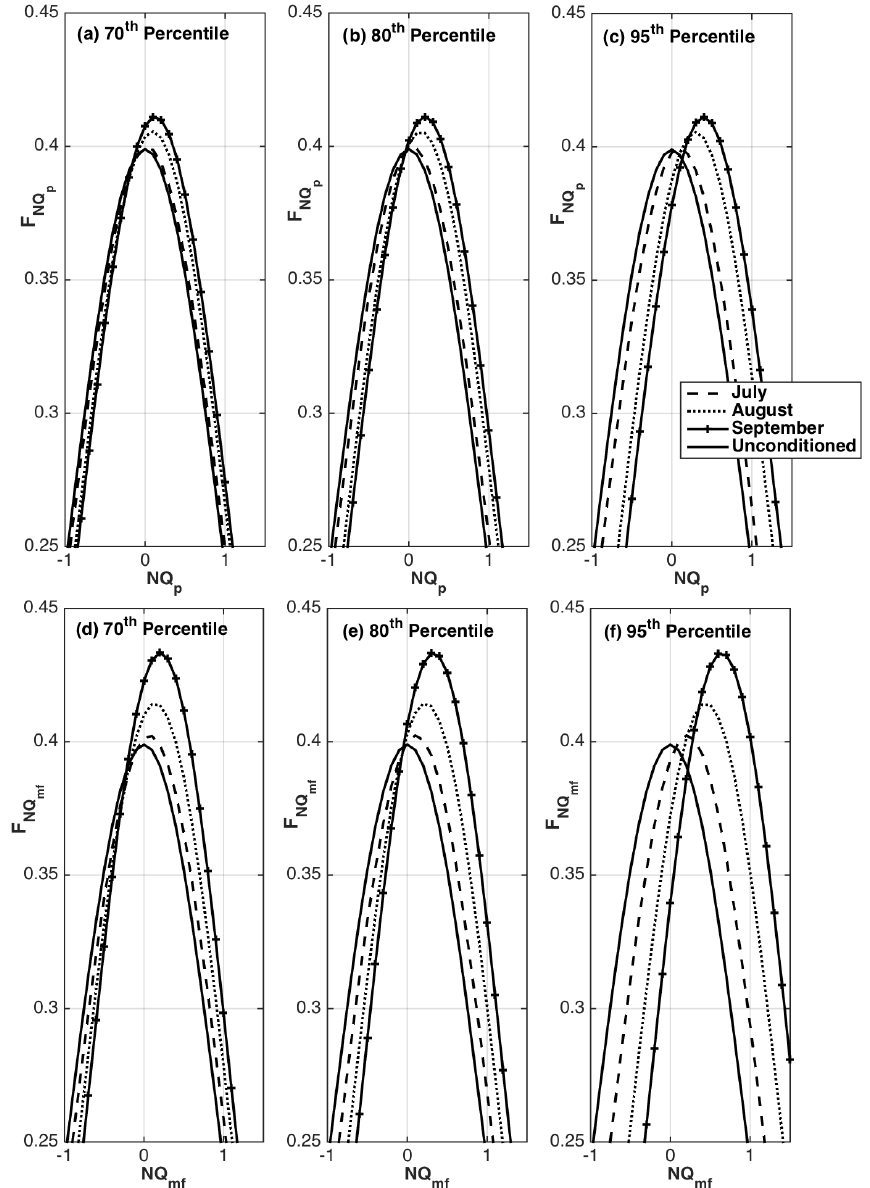
Figure 5. Probability distribution functions of the normalized dependent variables (NQ p and NQ mf ) conditioned to the occurrence of the 70th, 80th and 95th percentiles of the normalized variables in the pre-flood season in the Po